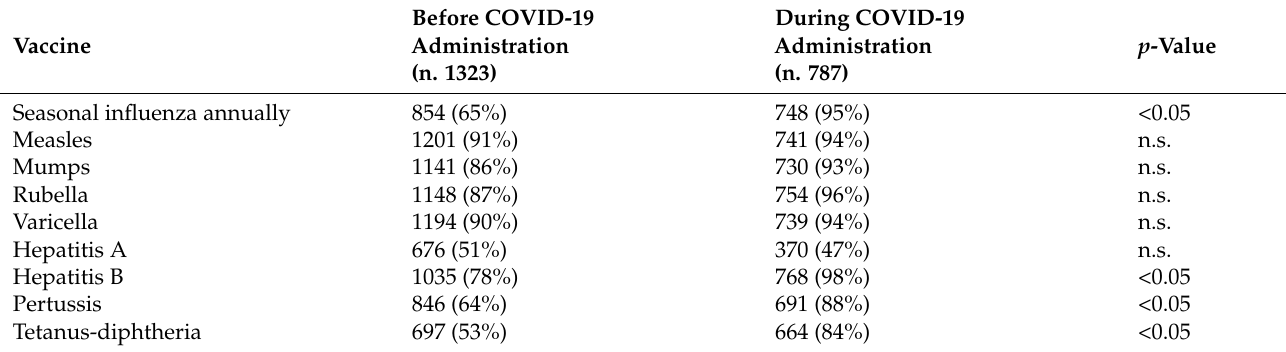
Table 2. HCP’s knowledge of Italian Vaccination Plan recommended vaccines, the correct response.